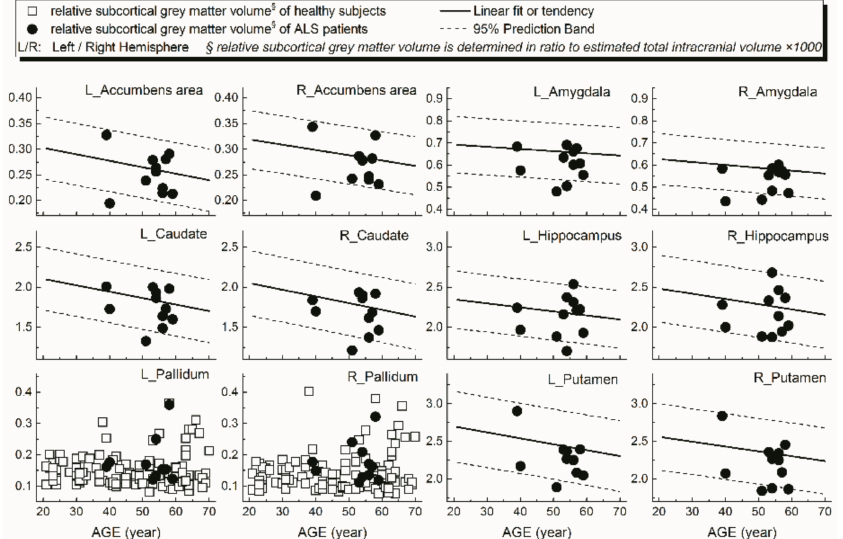
Figure 4. Relative volumes ( y -axis) measured from subcortical grey matter structures of ALS pa- tients in 12 ROIs (dot) together with the normative reference data, which were represented either by the prediction interval bands together with the linear fits or by the measured values of the healthy